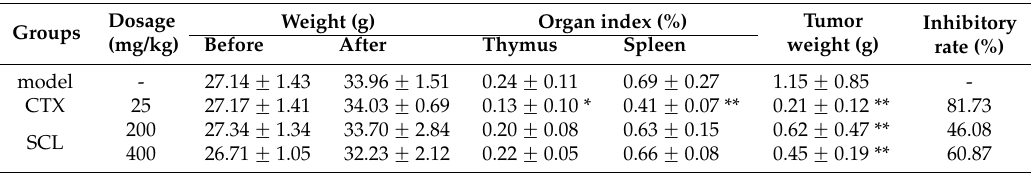
Table 1. Effects of steamed C . lanceolata (SCL) on tumor weights and relative organ index in H22 tumor-bearing mice. CTX, cyclophosphamide.